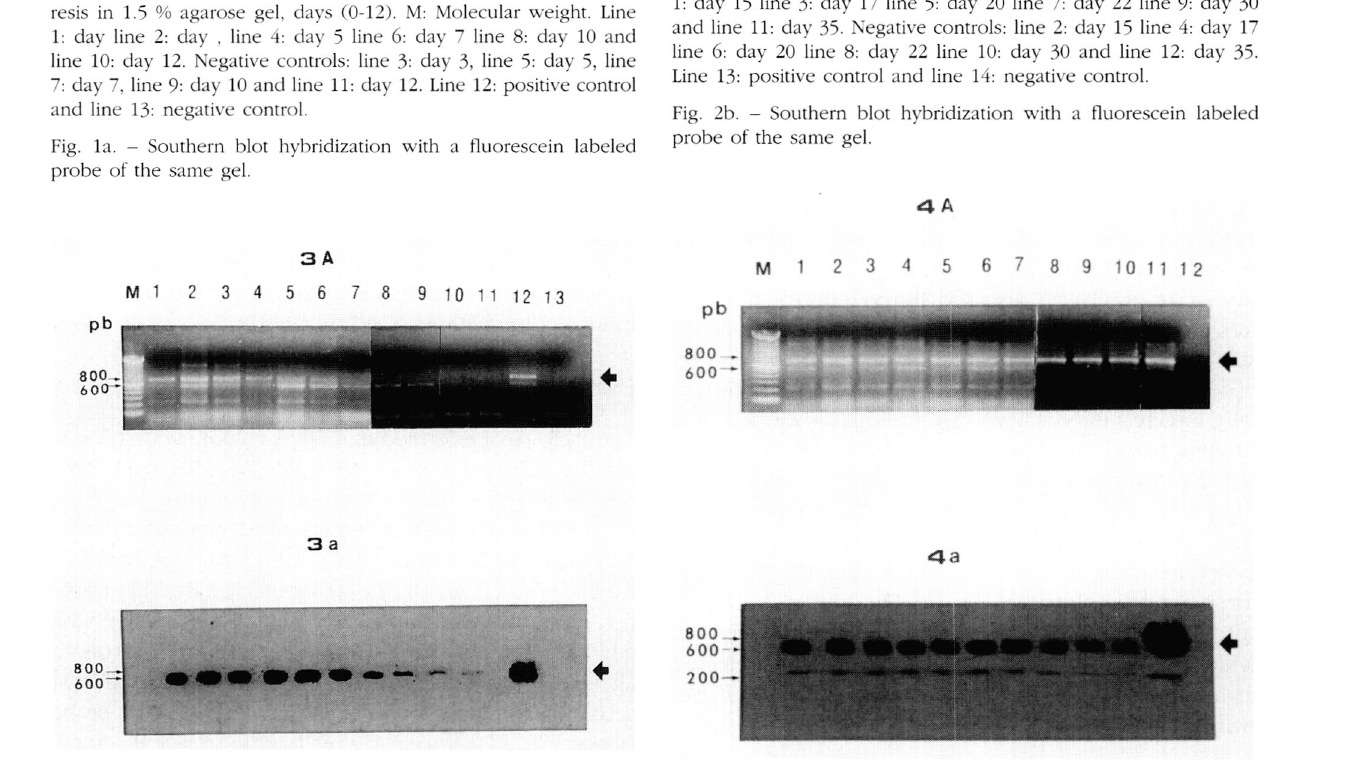
Fig 3A. - T spiralis: PCR products were analysed by electrophoresis in 1.5 % agarose gel. M: Molecular weight. Line 1: 500 ng; line 2: Fig. 3a. - Southern blot hybridization with a fluorescein labeled probe of the same gel.